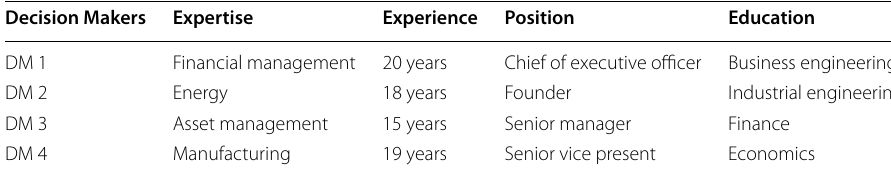
Table 1 Details of decision makers